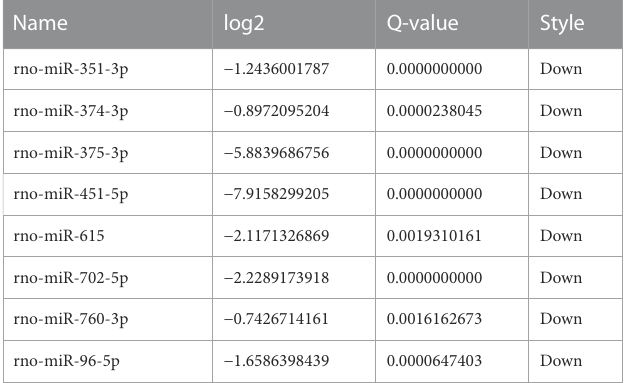
TABLE 3 Data related to differentially expressed microRNAs in the AR/C group. TABLE 3 ( Continued ) Data related to differentially expressed microRNAs in the AR/C group.